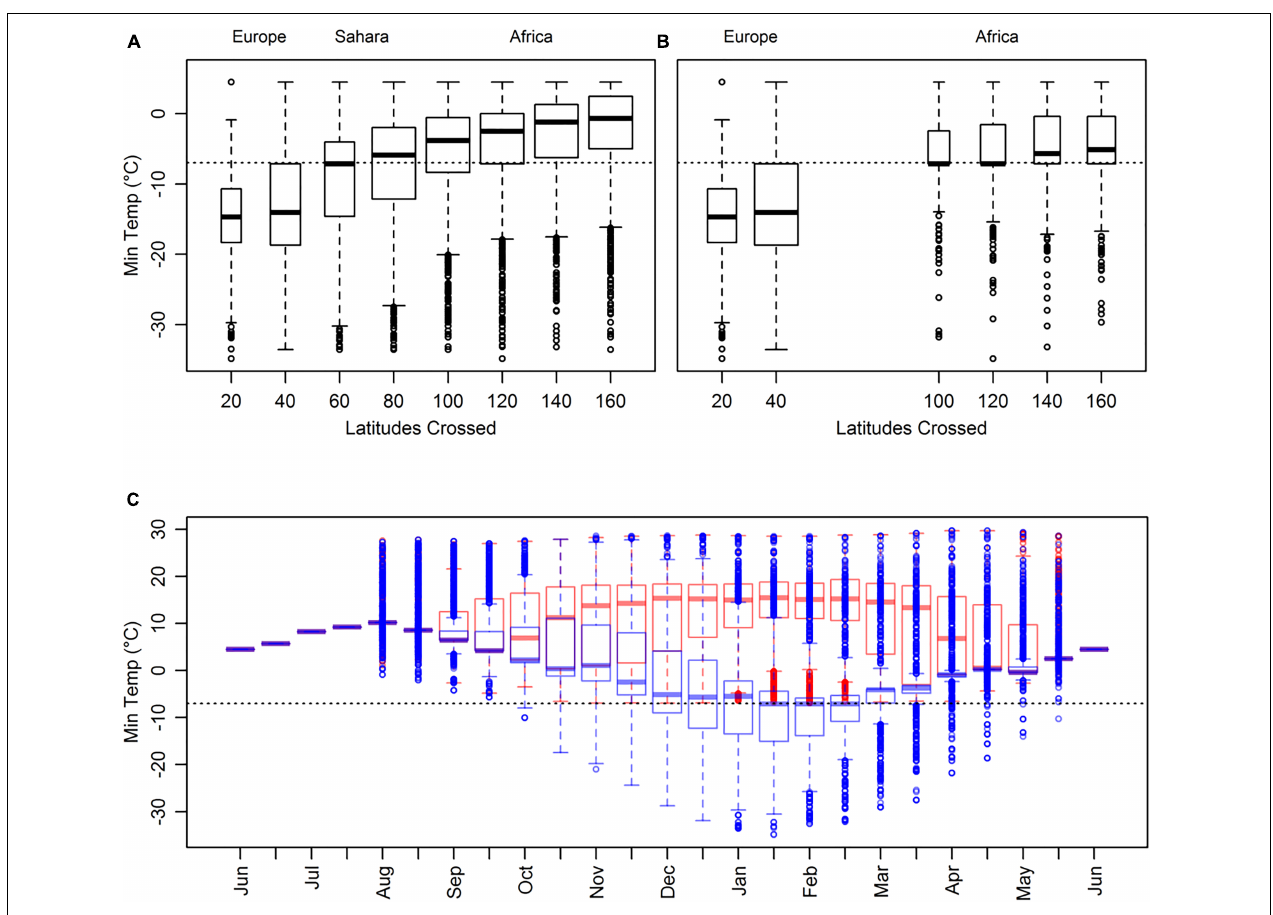
FIGURE 1 | Absolute minimum temperature ( ◦ C) encountered over the complete round-trip for simulated tracks grouped by the total number of latitudes crossed for (A) all tracks n = 11692 and (B) only tracks that do not use the Sahara region n = 2520. The dotted line indicates the − 7 ◦ C threshold used to partition tracks more likely to cross the Sahara Region from those in Europe. Latitudes crossed are the accumulated latitudes from the breeding site to the breeding site, i.e., a track crossing 20 latitudes had a southern extent 10 ◦ south of the breeding site. (C) Minimum temperature ( ◦ C) for tracks that did not use the Sahara region, for each temporal period. Tracks are partitioned by minimum temperature experienced: tracks maintaining temperatures above –7 ◦ C ( n = 798 ) in red and those with at least one period with temperatures below this in blue ( n = 1722 ). Whiskers represent the 95% confidence interval and outliers are shown by dots. Variable widths of boxplots represent the sample